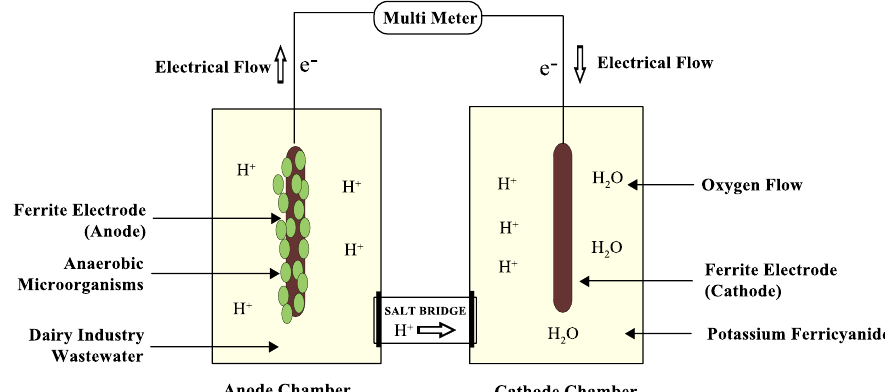
Fig. 1a: Schematic diagram of double chambered salt bridge microbial fuel cell